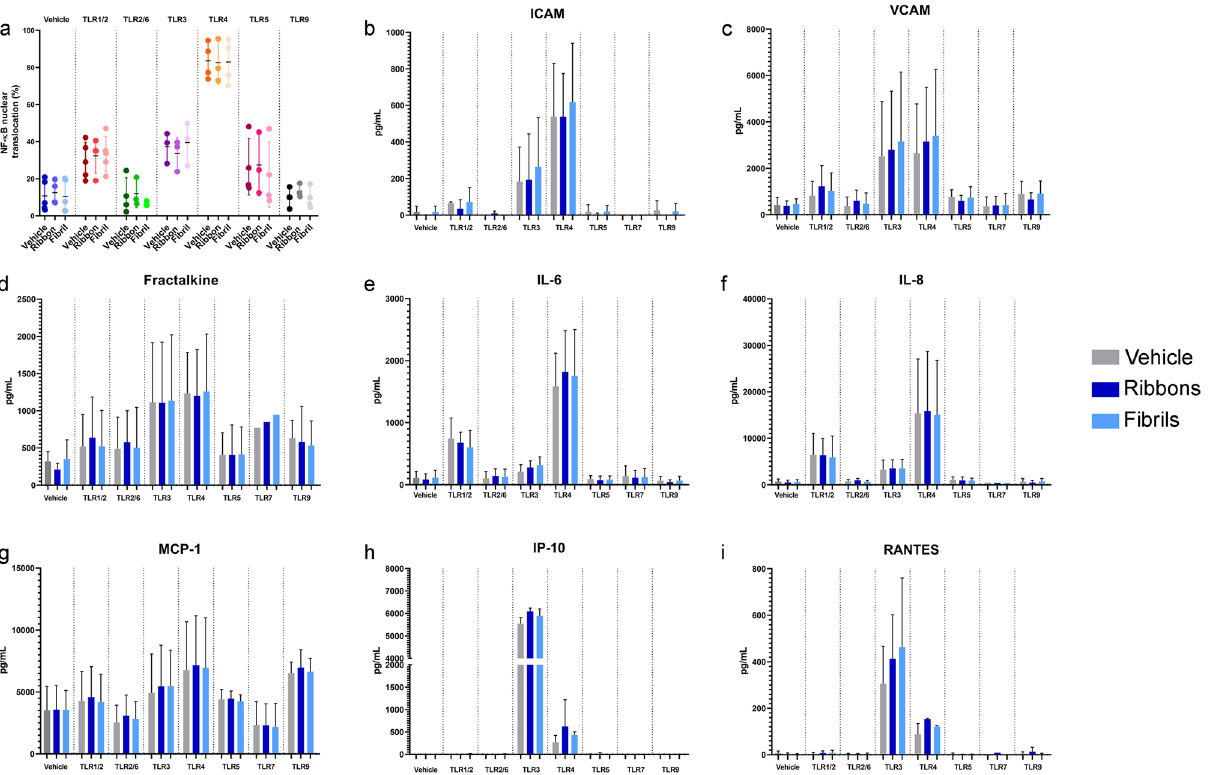
Figure 3. TLR ligands and α-syn treatment on pericytes. Inflammatory responses of primary human brain pericytes when treated with vehicle, ribbons (100 nM), fibrils (100 nM) and TLR ligands (Supplementary Table S5). Immunocytochemistry quantification of ( a ) NF-κB nuclear translocation after 1 h treatment. Conditioned media were taken and cytokine secretion analysed by cytometric bead array after 24 h.